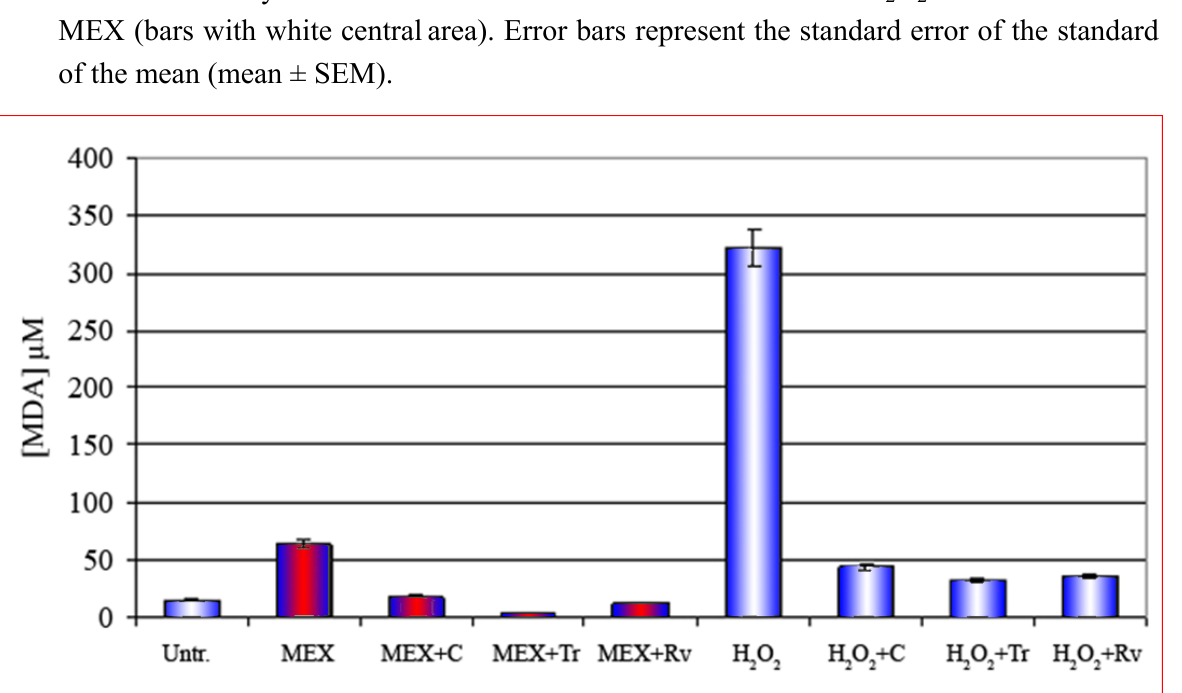
O in the absence of 2 2